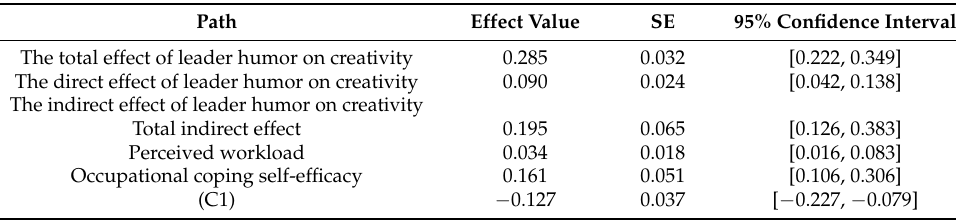
Table 4. Total, direct, and indirect effects of leader humor on creativity.